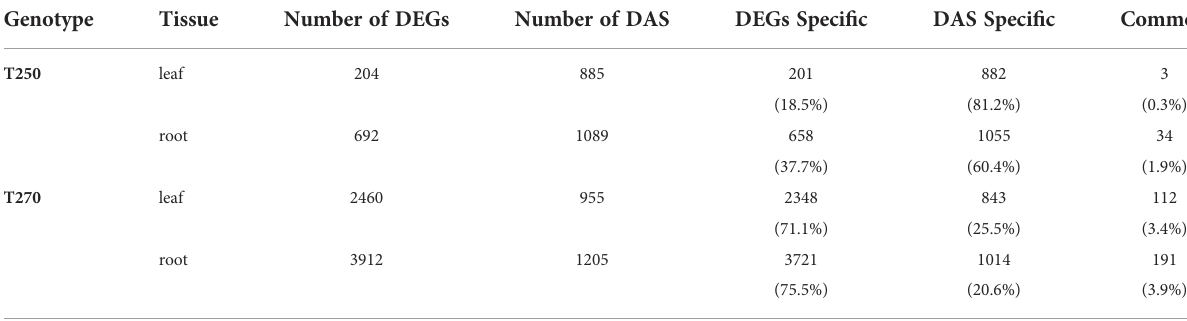
TABLE 4 Number and fraction of DEGs and DAS genes in T250 and T270 leaf and root in combined stress condition.